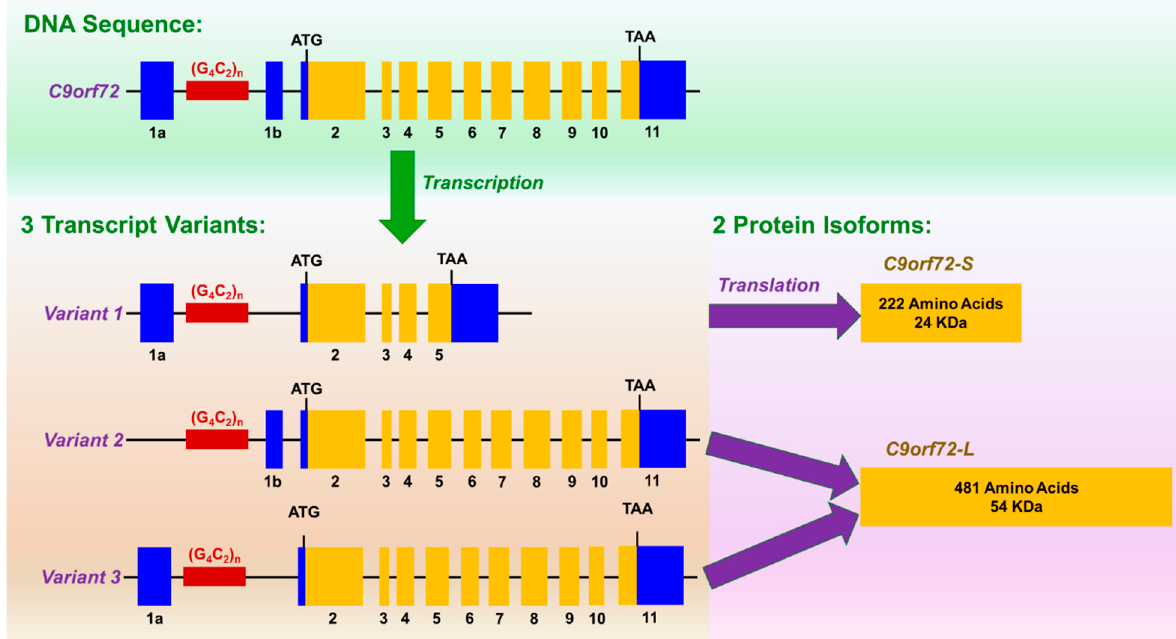
Figure 2. DNA sequence, three transcription variants, and two protein isoforms of C9orf72 . The 11-exon-containing C9orf72 gene undergoes alternative splicing, producing three transcript variants. The (G 4 C 2 ) n repeat expansion mutation (dark red region) is located in intron 1 of variants 1 and 3, whereas in variant 2, it is located within the promoter region. Coding exons are represented in orange and non-coding exons in blue (not to scale).